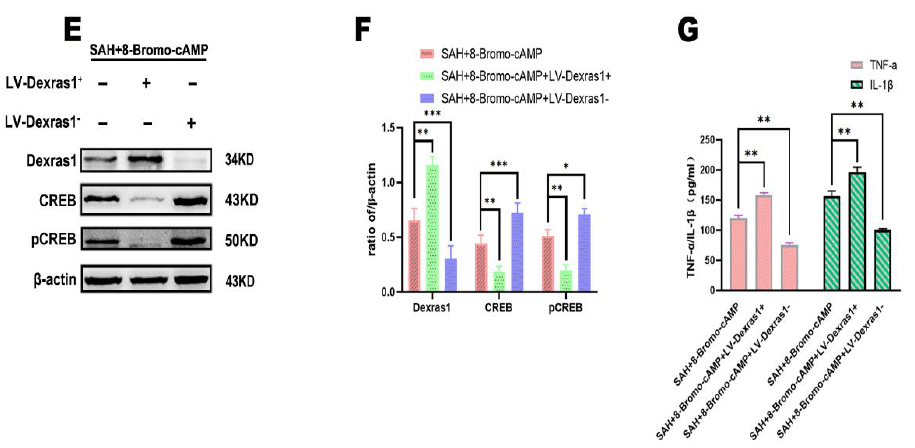
Figure 8. ( A ) Representative Western blots of Dexras1, CREB, and pCREB expression after in vitro sub- arachnoid hemorrhage with the activation by different 8-Bromo-cAMP sodium salts; ( B ) Western blot analysis of Dexras1, CREB, and pCREB. Results are percentages relative to β -actin levels. (* p < 0.05); ( C ) the results of ELISA used to detect IL-1 β and TNF- α levels, (** p < 0.01); ( D ) immunofluores- cence detection of oligodendrocyte precursor cell line differentiation after in vitro subarachnoid hemorrhage in each group, co-culture of SAH+8-Bromo-cAMP group neurons and oligodendrocyte cells treated with IGF − 1 (a), co-culture of SAH+8BMP+Dexras1 + group neurons and oligodendro- cyte cells treated with IGF − 1 (b), co-culture of SAH+8-Bromo-cAMP+Dexras1 - group neurons and oligodendrocyte cells treated with IGF − 1 (c), OPCs (NG2, red), OLGs (CNPase, green). Scale bars: ea = 25 µ m. (* p < 0.05, ** p < 0.01); ( E ) representative Western blots of Dexras1, CREB, and pCREB after 8-Bromo-cAMP sodium salt treatment combined with Dexras1 overexpression or knockdown after subarachnoid hemorrhage in vitro; ( F ) Western blot semi-quantitative analysis of Dexras1, CREB, and pCRE. Results are percentages relative to β -actin levels. (* p < 0.05, ** p < 0.01, *** p < 0.001) ( G ). ELISA results show IL-1 β and TNF- α levels. (** p <